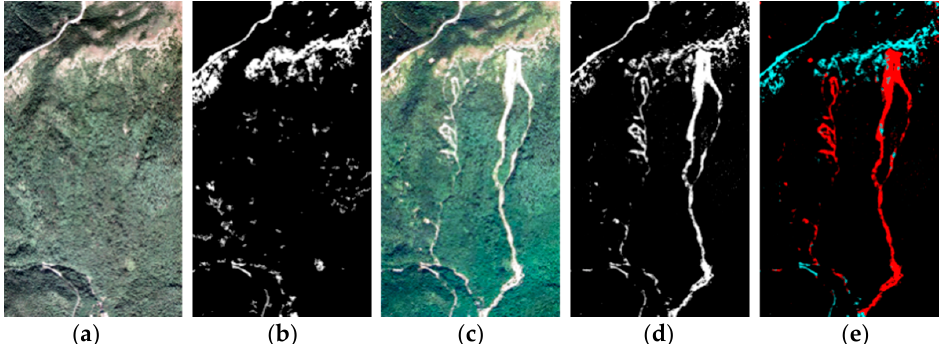
Figure 10. Landslide mapping using change detection based on image structuring information ( T 1 = 0.8, the grayscale value of the image is normalized from 0 to 1): ( a ) pre-event image; ( b ) candidate false landslide regions L pre ; ( c ) post-event image; ( d ) candidate landslide regions L post ; and ( e ) detected landslide regions according to L pre and L post , where regions marked by red color represent true landslide regions and regions marked by cyan color represent removed false landslide regions.